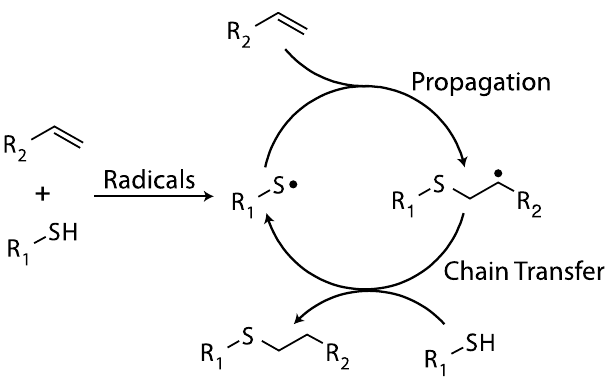
Figure 10. Thiols and electron-rich carbon-carbon double bonds form thioether linkages via radical-mediated, alternating propagation and chain transfer reactions [82,83]. Arrows show reaction direction.